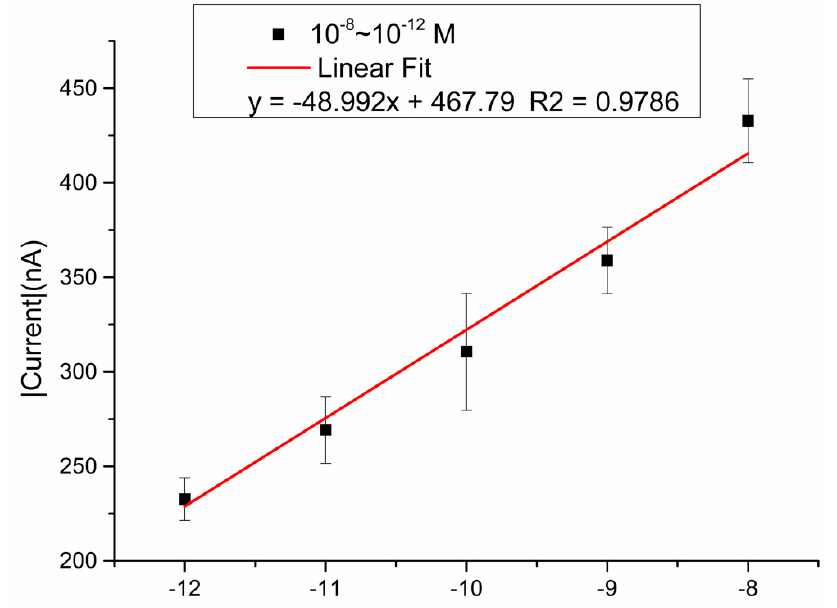
Figure 7. Demonstration of the mimic samples in different concentrations from 10 − 12 to 10 − 8 M, y = − 48.992x + 467.79, and R squared is 0.9786.